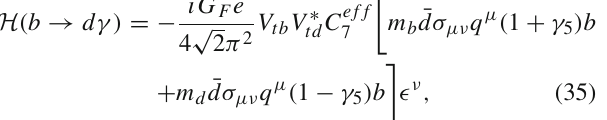
Fig. 3 The BS wave function for (cid:2) b